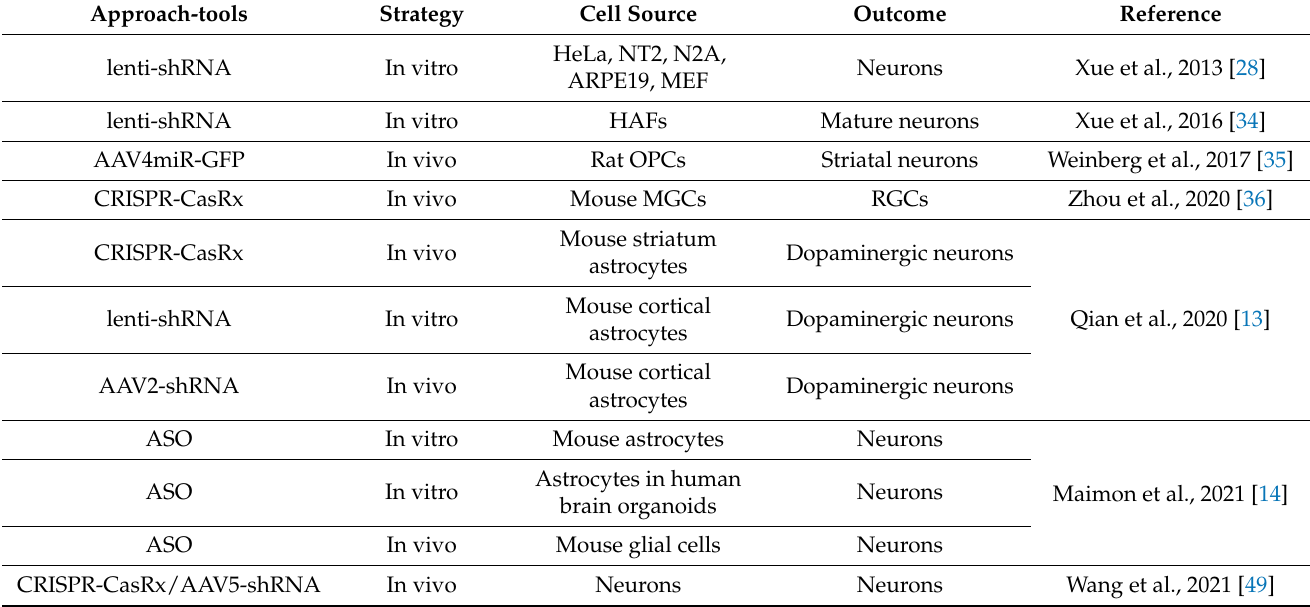
Table 1. Summary of PTB-silencing approaches reported in the review. NT2 = human